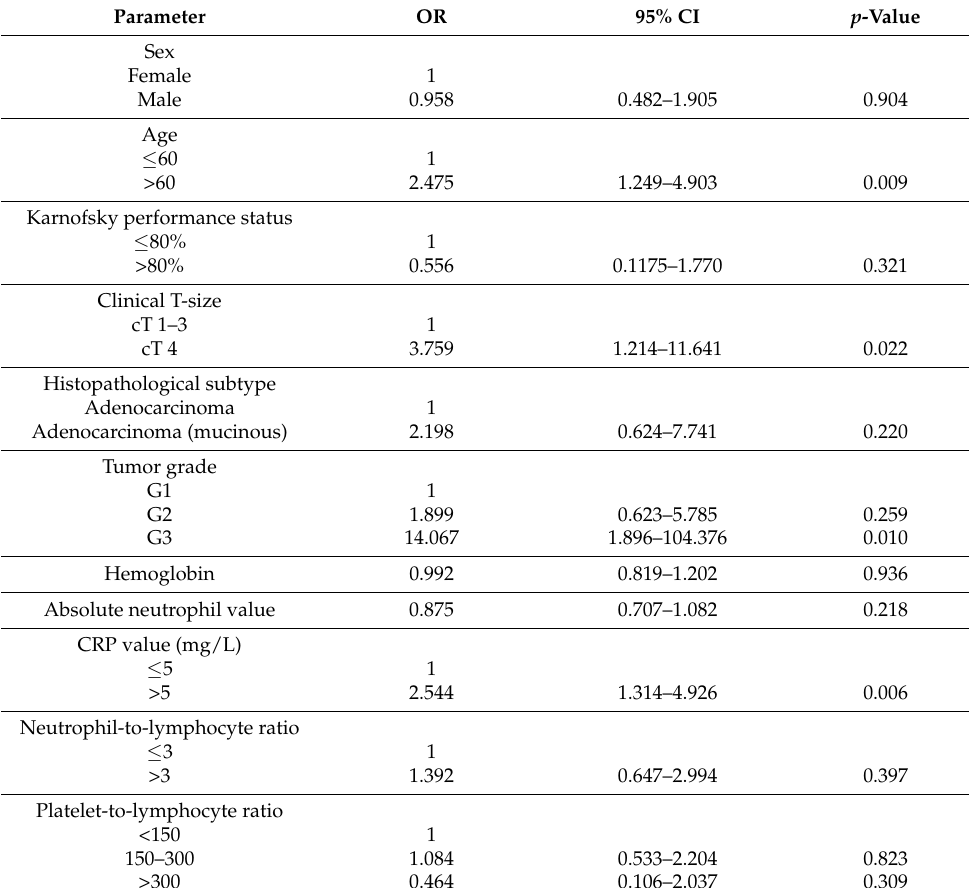
Table 3. Parameters predictive for sphincter-preserving surgery in multivariable